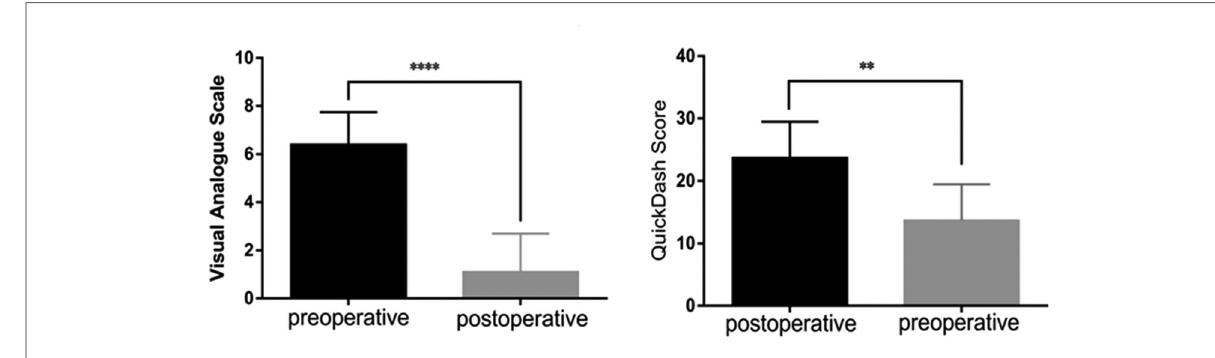
FIGURE 6 (Left) VAS values for pain. (Right) Quick-DASH score outcomes. ** p =0.001 and **** p <0.0001.